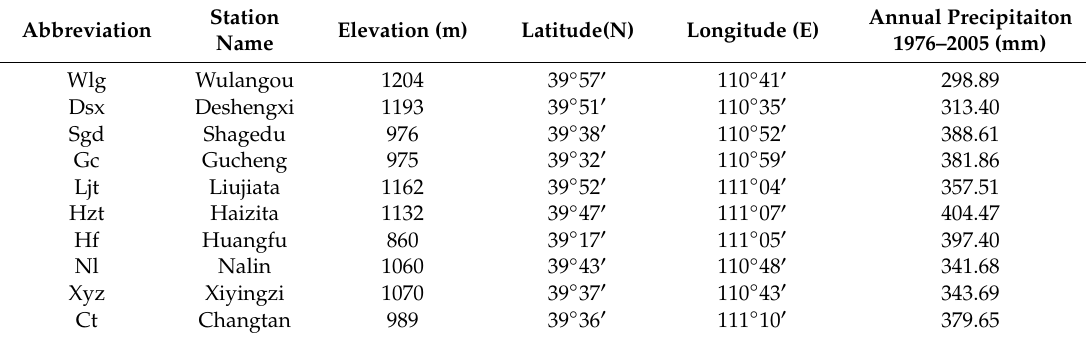
Table 1. Precipitation stations and hydrological stations in the Huangfuchuan